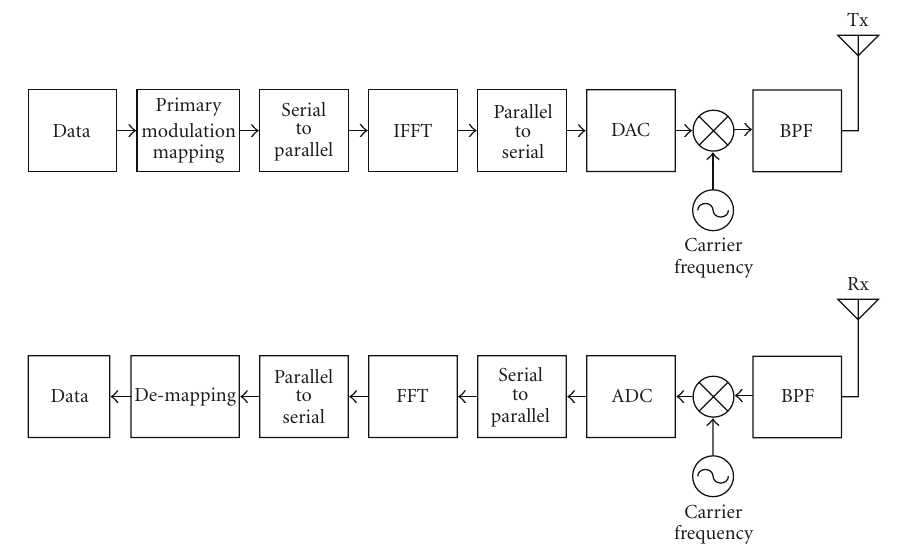
Figure 1: OFDM transmitter-receiver